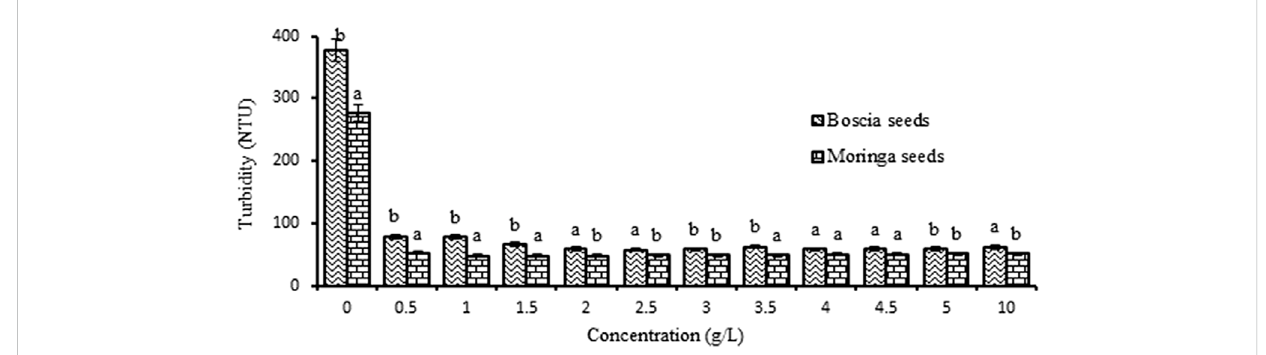
FIGURE 6 Measurement of turbidity of water samples treated with different concentrations of Moringa oleifera (Mo)seeds and Boscia senegalensis (Bs) seeds.